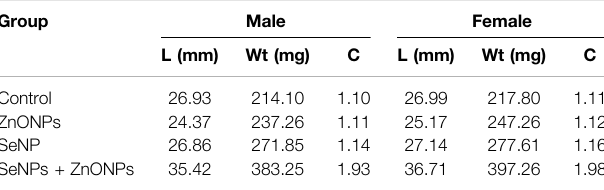
TABLE 1 | Length (L) – weight (Wt) and the condition factor (C) and sex separated for each treatment and the control group.